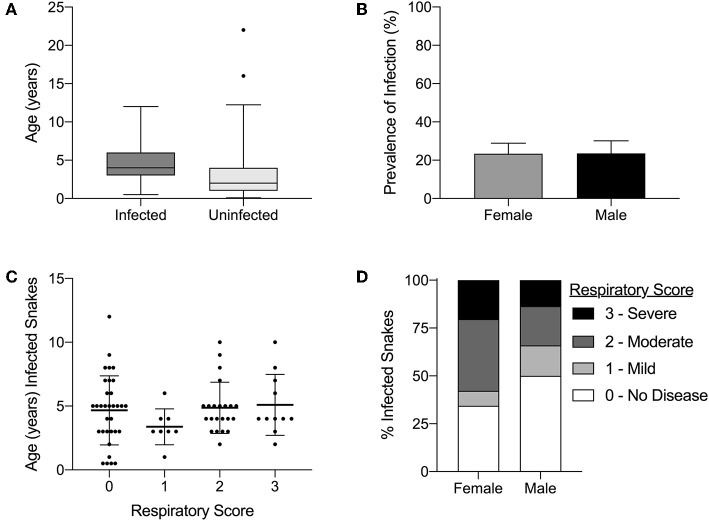
Serpentovirus infection is statistically associated with age but not with sex; clinical signs are not statistically associated with age or sex. (A) Comparison of ages between serpentovirus-infected and uninfected snakes. Average ages: 4.7 (infected) and 2.6 (uninfected). Binary logistic regression; p-value ≤ 0.001. Box and whisker plot 1–99 percentile. (B) Prevalence of infection in male and female snakes. Female prevalence: 23.4%, 95% CI 18.7–28.9%. Male prevalence: 23.5%, 95% CI 18–30.1%. Binary logistic regression; p-value = 0.144. (C) Comparison of respiratory score to age in serpentovirus-positive snakes. Kruskal-Wallis test (one-way ANOVA on ranks, non-parametric); p-value = 0.32. Scatter dot plot mean with standard deviation. (D) Comparison of respiratory score with sex in serpentovirus-positive snakes. Mann-Whitney U test; p-value = 0.06. Stacked bar graph representing the number of snakes with each respiratory score as a fraction of the total (100%).